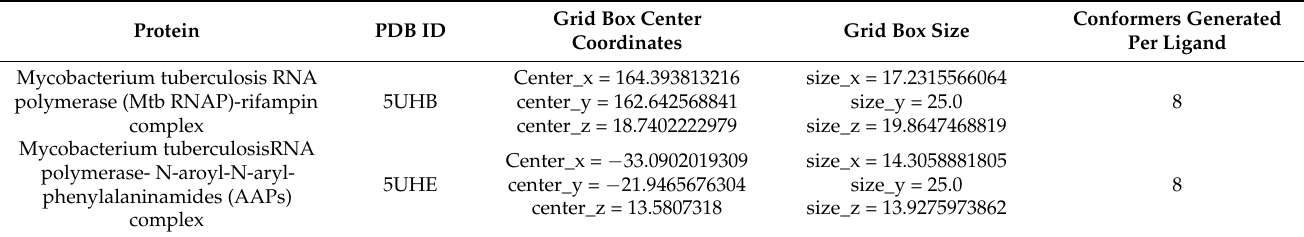
Table 9. Molecular docking parameters and protein